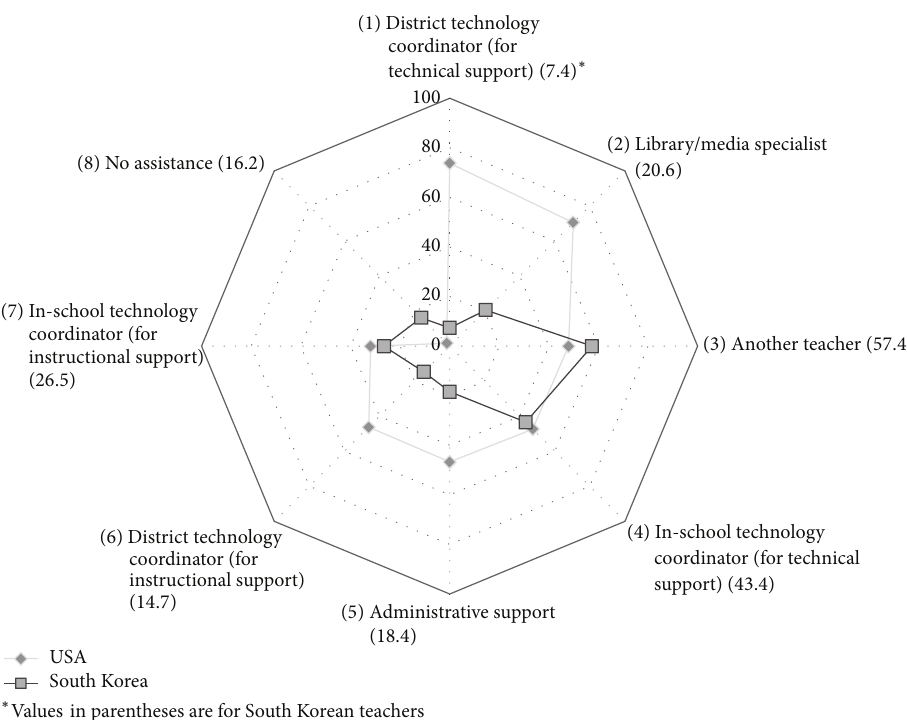
Figure 2: Percent of respondents indicating availability of technical